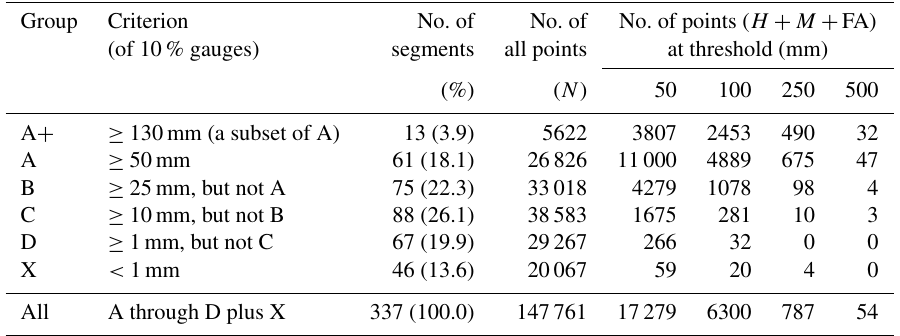
Table 2. The classification criteria using (at least) 10% of rain gauges with highest 24h accumulated rainfall (00:00–24:00 or 12:00– 12:00UTC) over Taiwan and the results in the number of 24h segments (and percentage) and total points (sites) of H + M + FA at selected rainfall thresholds (mm) for the different groups. During the Mei-yu seasons of 2012–2014, the total N is 148776, and on average there are 442 rain gauges per segment. The points of H + M + FA are based on the statistics of day − 1 (0–24h) QPFs, and N is also given (with no threshold).